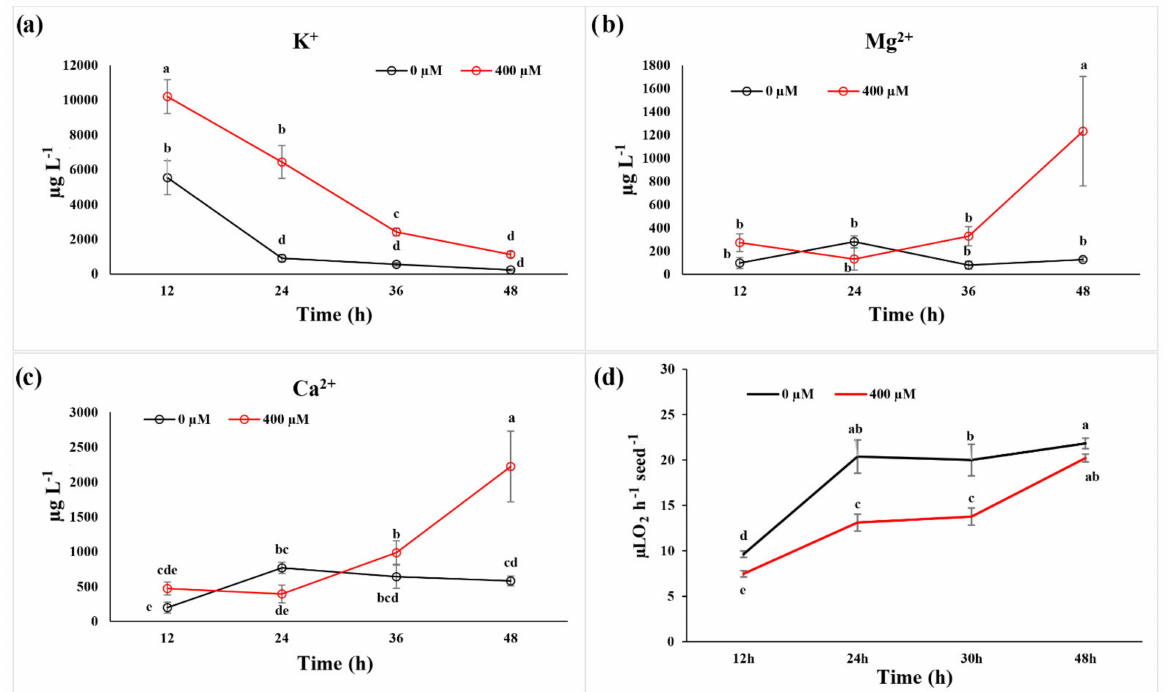
Figure 2. Effect of coumarin (400 µ M) on levels of ( a ) K + ; ( b ) Mg 2+ and ( c ) Ca 2+ in the incubation medium during the first 48 h of seed germination in R. sativus . ( d ) Time-course monitoring of the effects of coumarin (400 µ M) on seed respiration. Data are the means + SD and analysed through two-way ANOVA using the LSD test as post hoc ( p ≤ 0.05). Different letters along the curves indicate statistical differences among the treatments. N = 3.